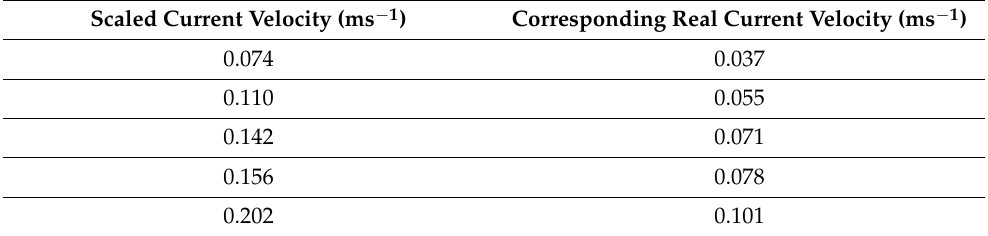
Table 2. Scaled current velocities and corresponding real current velocities.